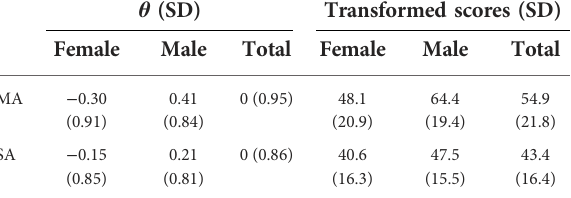
TABLE 10 Movement competence, rules, and tactics mean scores strati fi ed by sex for manipulative-based activities (MA) and stability- based activities